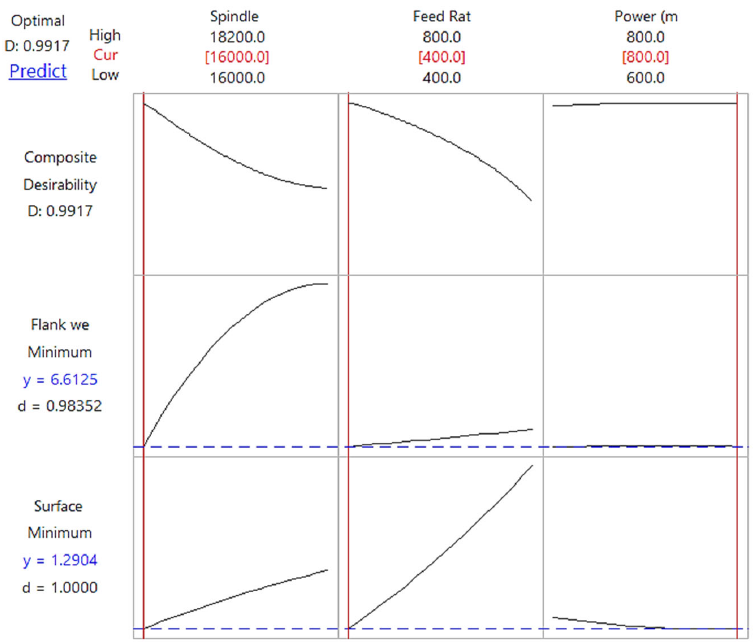
Figure 12. Response optimization plot of cutting parameters and the predicted results of flank wear and surface roughness with conventional cutting fluid. Table 12. Experimental and predicted values of surface roughness, flank wear at the optimum levels.